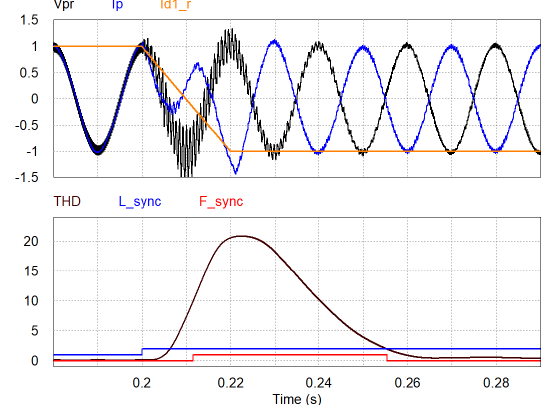
Figure 26. Resonance caused by changing from traction to regeneration mode, starting at t =0.2 s, in single-side feeding scheme. Traces: Vpr - primary voltage, Ip - primary current, Id1_r - reference value for the active current component of converter 1, THD - total harmonic distortion, L_sync - loss of synchronism, F_sync - fault of